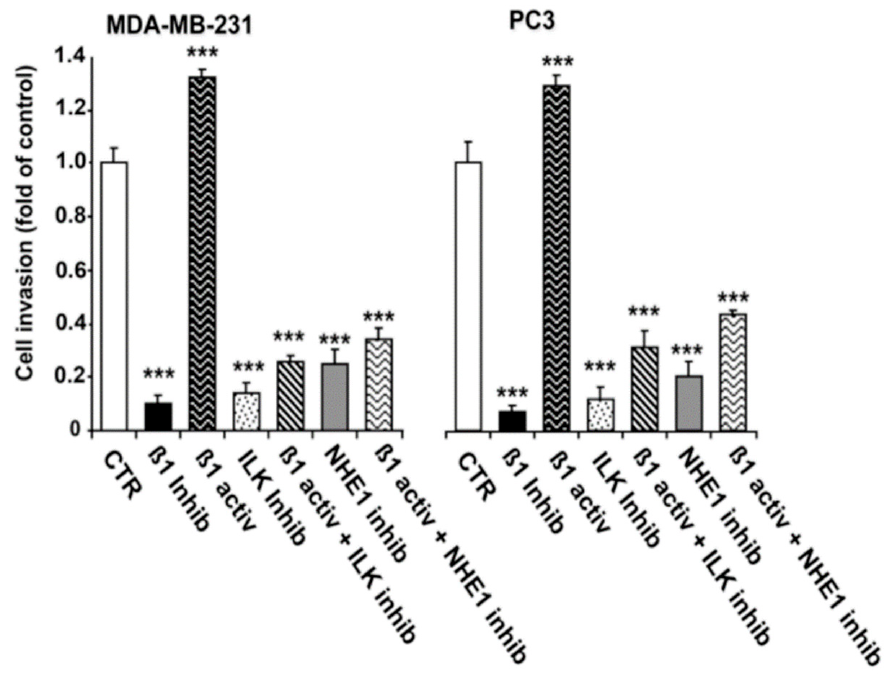
Figure 4. ILK and NHE1 activity are necessary for β 1-integrin-driven invasion. To examine the roles of ILK and NHE1 in an invasive capacity, MDA-MB-231 and PC3 cells were stimulated with the β 1 integrin activating antibody and treated with either the ILK inhibitor or the β 1 integrin inhibiting antibody in the presence or absence of the specific NHE1 inhib- itor, cariporide. Cell invasion was analyzed quantitatively by fluorescent labeling of cells that had traversed 8 µm polycarbonate membranes coated with 5 mg/mL Matrigel (Chemicon Int., Livermore, CA) as described in the Materials and Methods. Mean ± S.E.M., n = 4, *** p < 0.001 compared to control cells.